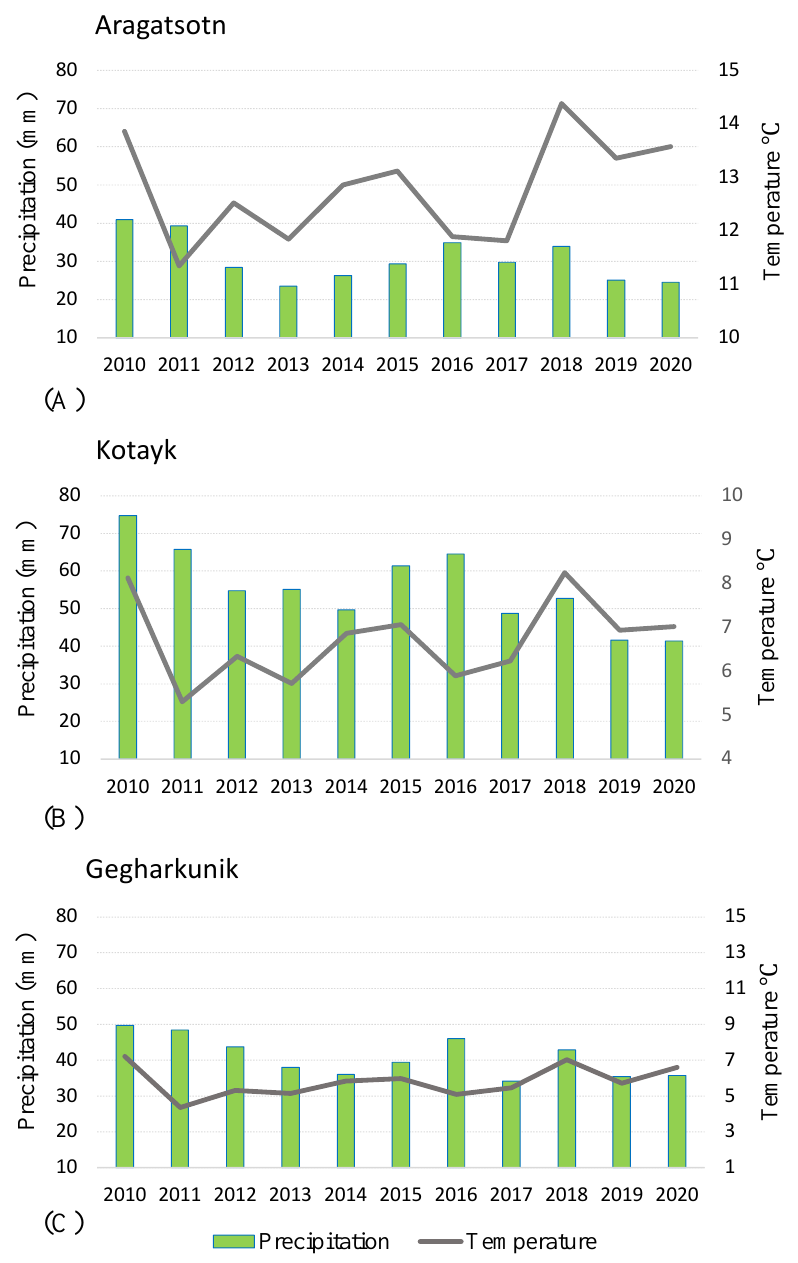
Figure 9. Average annual temperature and precipitation in Aragatsotn ( A ), Kotayk ( B ) and Gegharkunik ( C ) marzes of Armenia in 2010 – 2020.